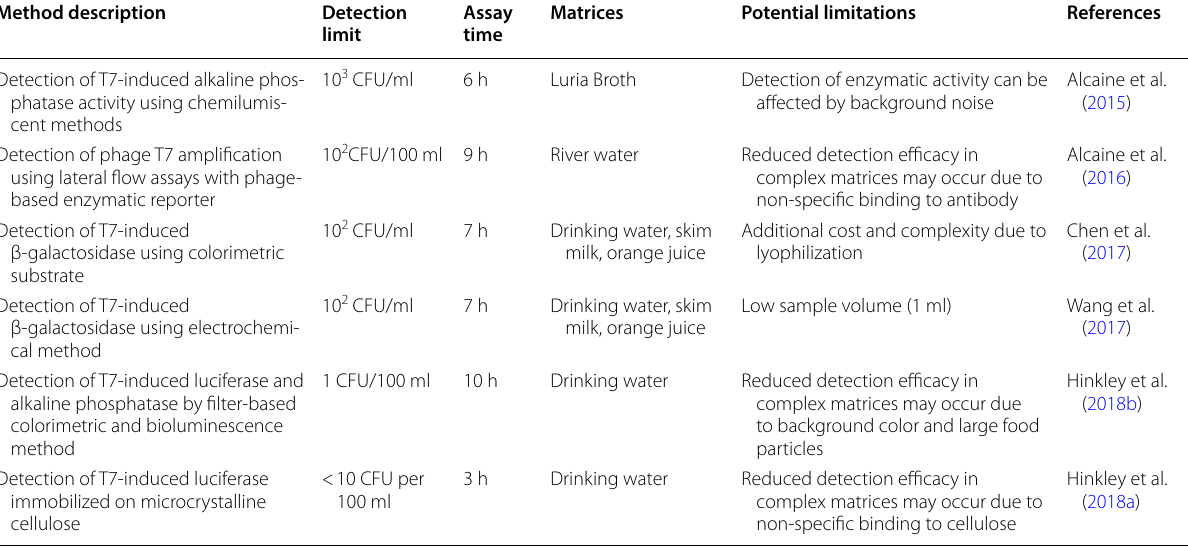
Table 1 Short summary of bacteriophage-based rapid bacteria detection studies using genetically engineered bacteriophage